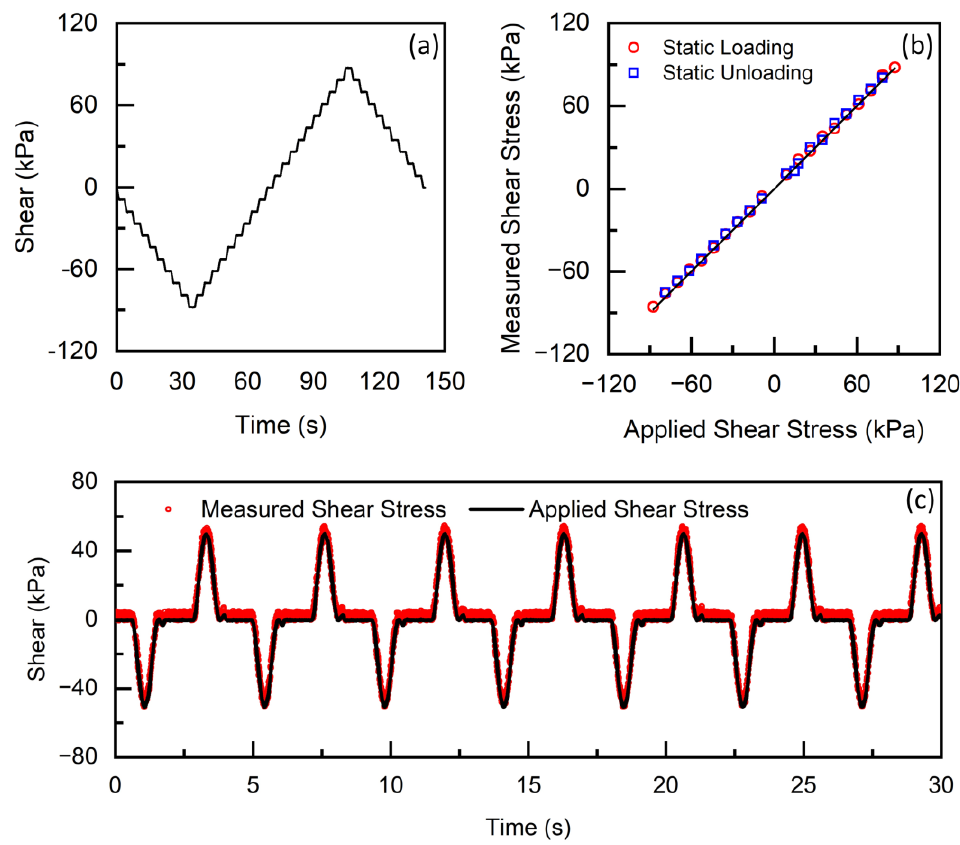
Figure 5. ( a ) Applied static shear stress from the mechanical test machine as a function of time. Measured shear stress from the insole system and applied shear stress from the test machine, obtained from the ( b ) static and ( c ) dynamic shear test.